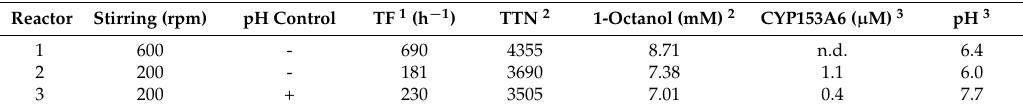
Table 2. Results from scale-up experiments performed using a Sixfors bioreactor system using 300 mL